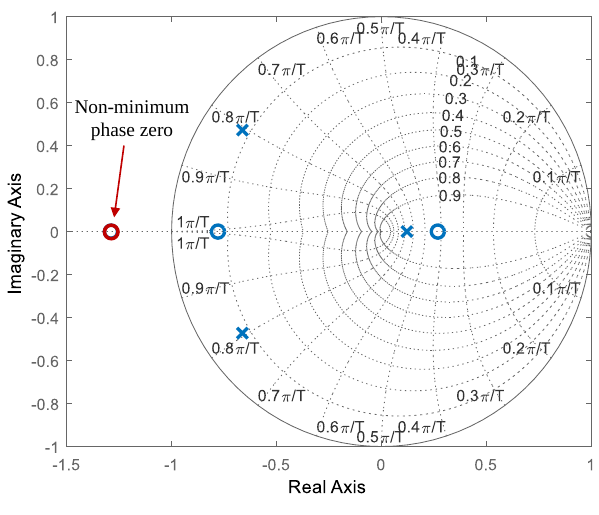
Figure 8. Pole-zero map of G u ( z )